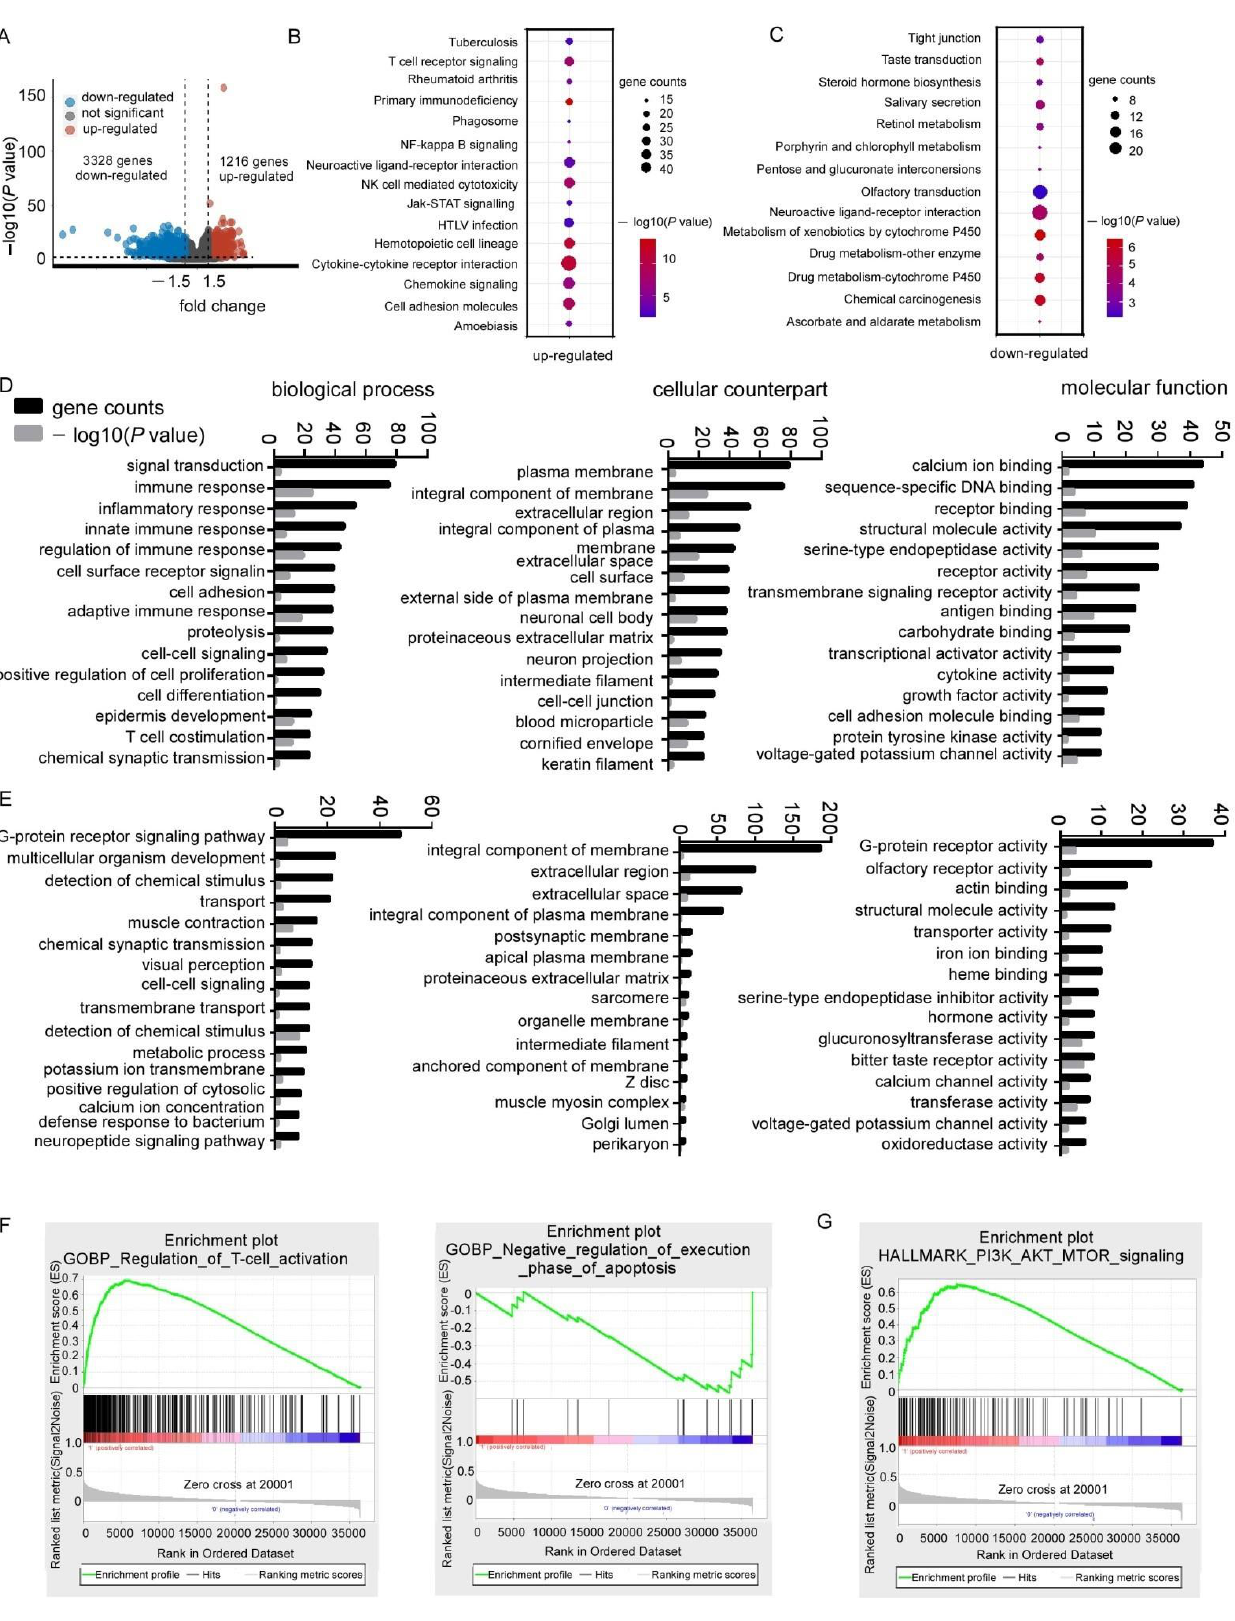
Figure 2. Gene ontology, KEGG pathway, and gene set enrichment analysis between PITPNM1 high expression group and PITPNM1 low group. ( A ) Volcano plot of differentially expressed genes between PITPNM1 high expression group